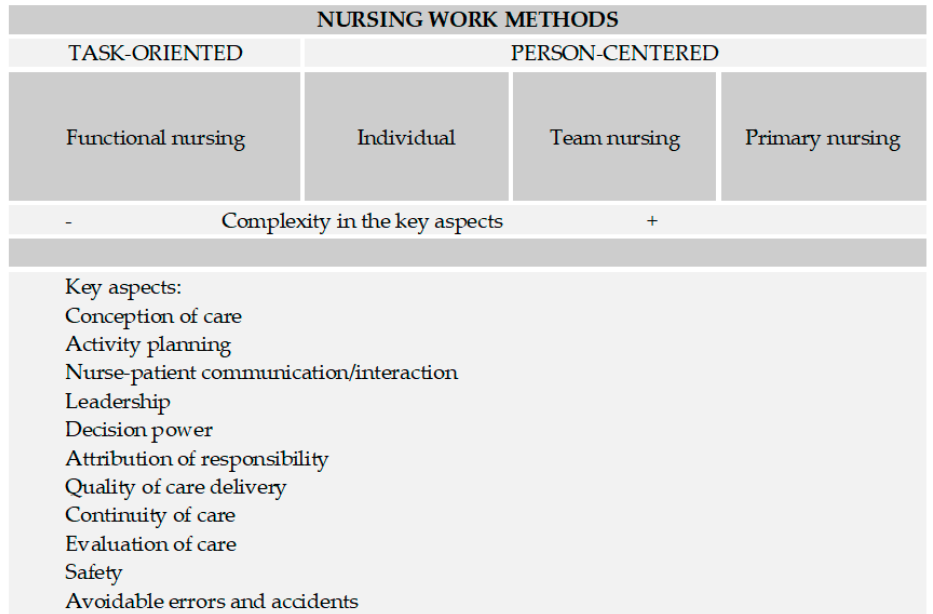
Figure 7. Key aspects of the methods of organization and delivery of nursing care.